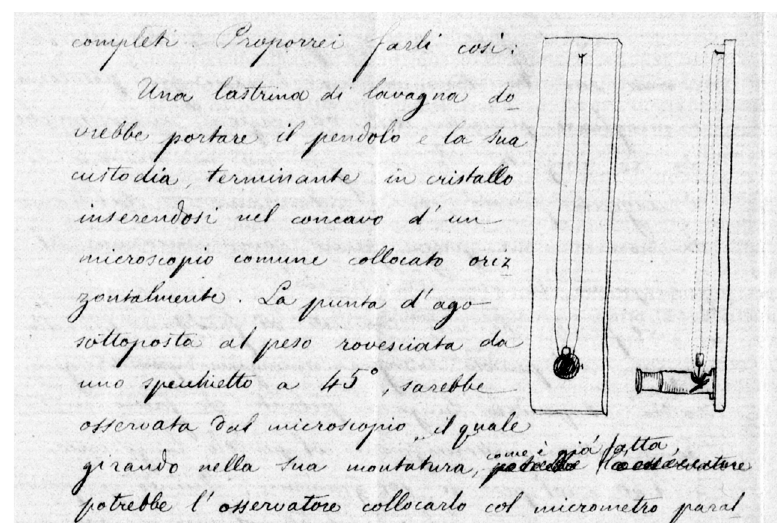
Fig. 3. Detail of a letter of M.S. De Rossi to Timoteo Bertelli, Rome, 10th March 1875, in which the scholar puts forward the definition and dissemination of a standard version of tromometer and makes a sketch of it (His- torical Archives of Barnabites,